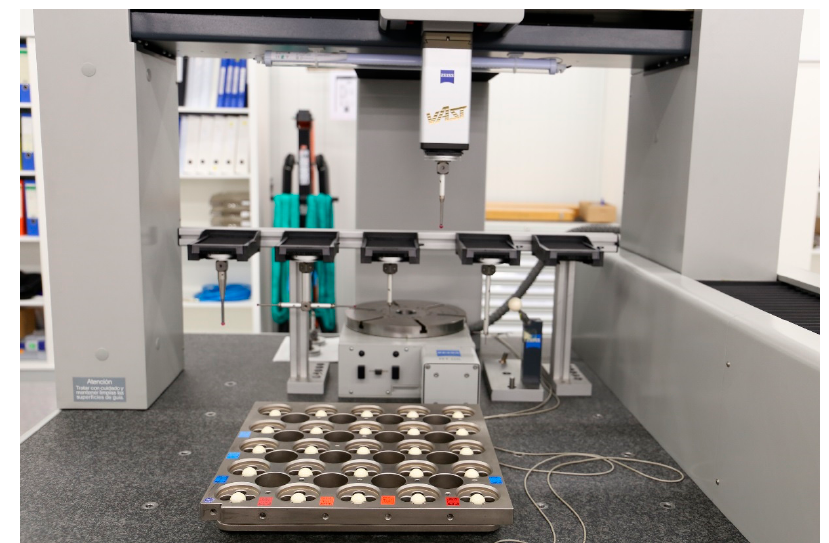
Figure 9. 3D artifact for CMM error characterization.